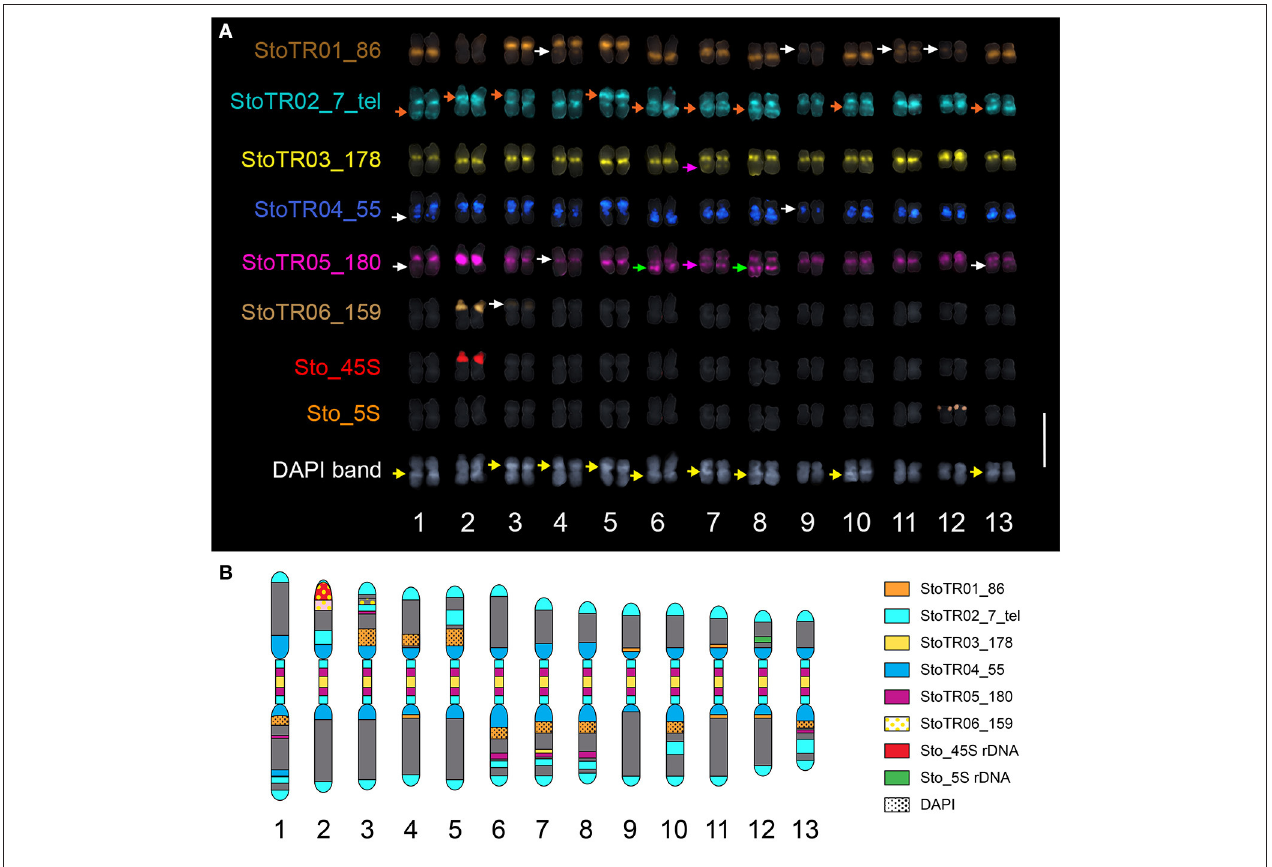
FIGURE 3 | Mitotic metaphase FISH karyogram of S. tora . (A) Chromosomal distribution of the eight independent tandem repeats showing mostly centromeric and pericentromeric localization. StoTR01_86 localized at paracentric regions of either short or long arms, except for chromosomes 4 and 11 which showed pericentric localization. StoTR02_7_tel showed extra-telomeric signals at the centromere and interstitial regions of either, but not both, chromosome arms (orange arrows). StoTR03_178 localized at centromeres of all chromosomes and at a weak locus in 7L which colocalized with StoTR05_180 (pink arrows). StoTR04_55 localized at pericentromeric regions in all chromosomes and a weak locus in 1L. StoTR05_180 was intense in the centromere of chromosome 2. Aside from centromeric regions, it was also observed at equilocal sites in the interstitial regions of some chromosomes (green, white, and pink arrows). StoTR06_159 showed an intense signal at the NOR site in chromosome 2S and a weak signal in chromosome 3S. One locus each was observed for the 45S and 5S rDNA families. Some chromosomes have inherent DAPI bands (yellow arrows). Note the colocalized StoTR06_159 and the NOR site in chromosome 2S. White arrows indicate weak signals. Bar = 10 µ m. (B) Karyotype idiogram of S. tora with stretched (peri)centromeric region. Chromosomal niches of different repeats are indicated by different colors and patterns. The dark gray background indicates the DAPI